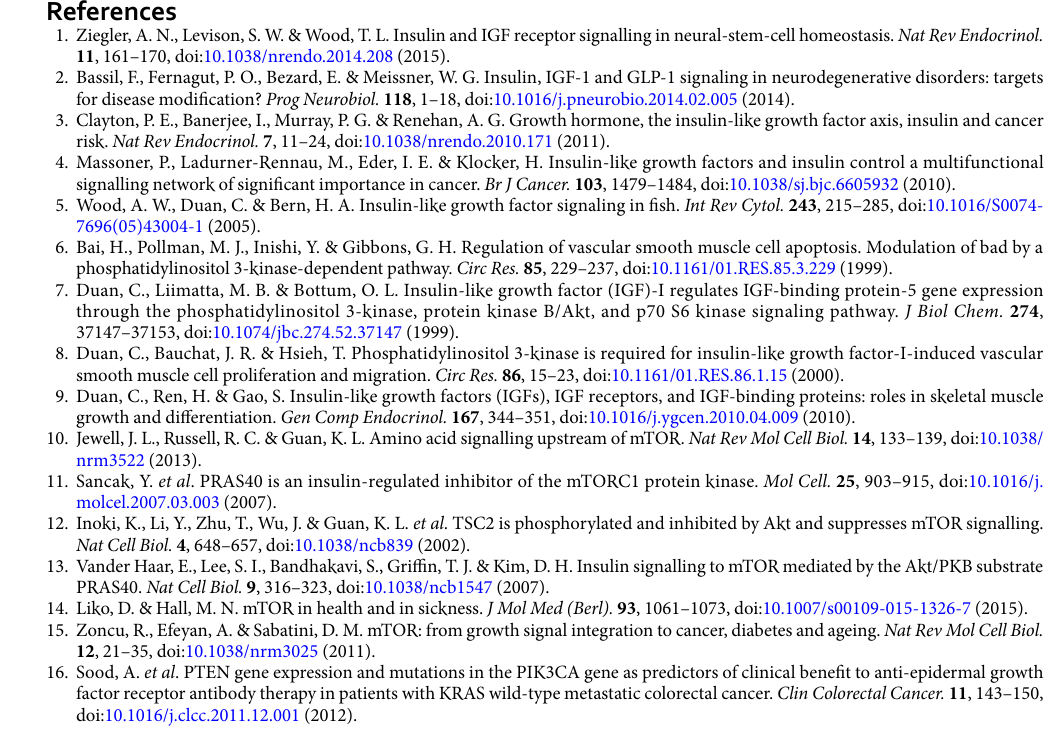
Flow Cytometry Analysis and Fluorescence-activated cell sorting